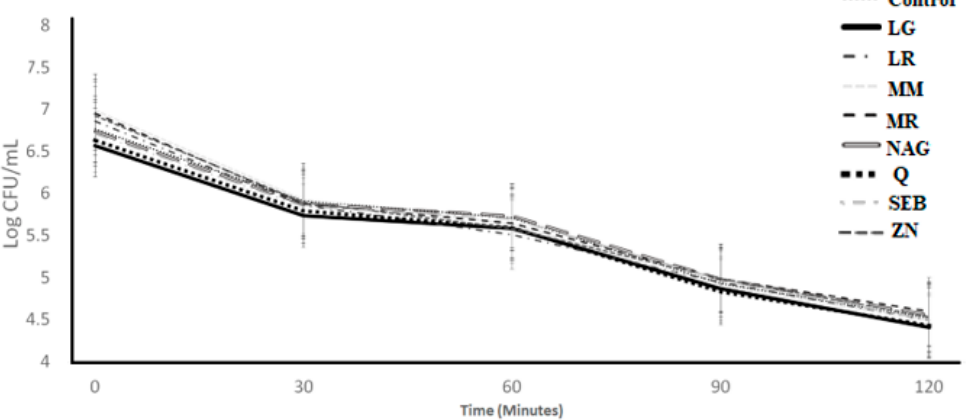
Figure 2. Log counts of Lactobacillus bulgaricus showing its acid tolerance as influenced by different ingredients over an incubation period of 120 min. C = control, LG = L-glutamine (7 g/L), Q = quercetin (700 mg/L), SEB = slippery elm bark (210 mg/L), MR = marshmallow root (1340 mg/L), NAG = N-acetyl-D-glucosamine (210 mg/L), LR = licorice root (210 mg/L), MM = maitake mushrooms (42 mg/L), and ZN = zinc orotate (70 mg/L). Error bars represent SE.